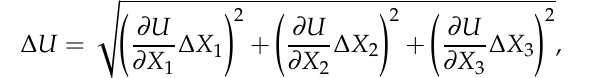
Figure 4. Roughness profile for polished copper